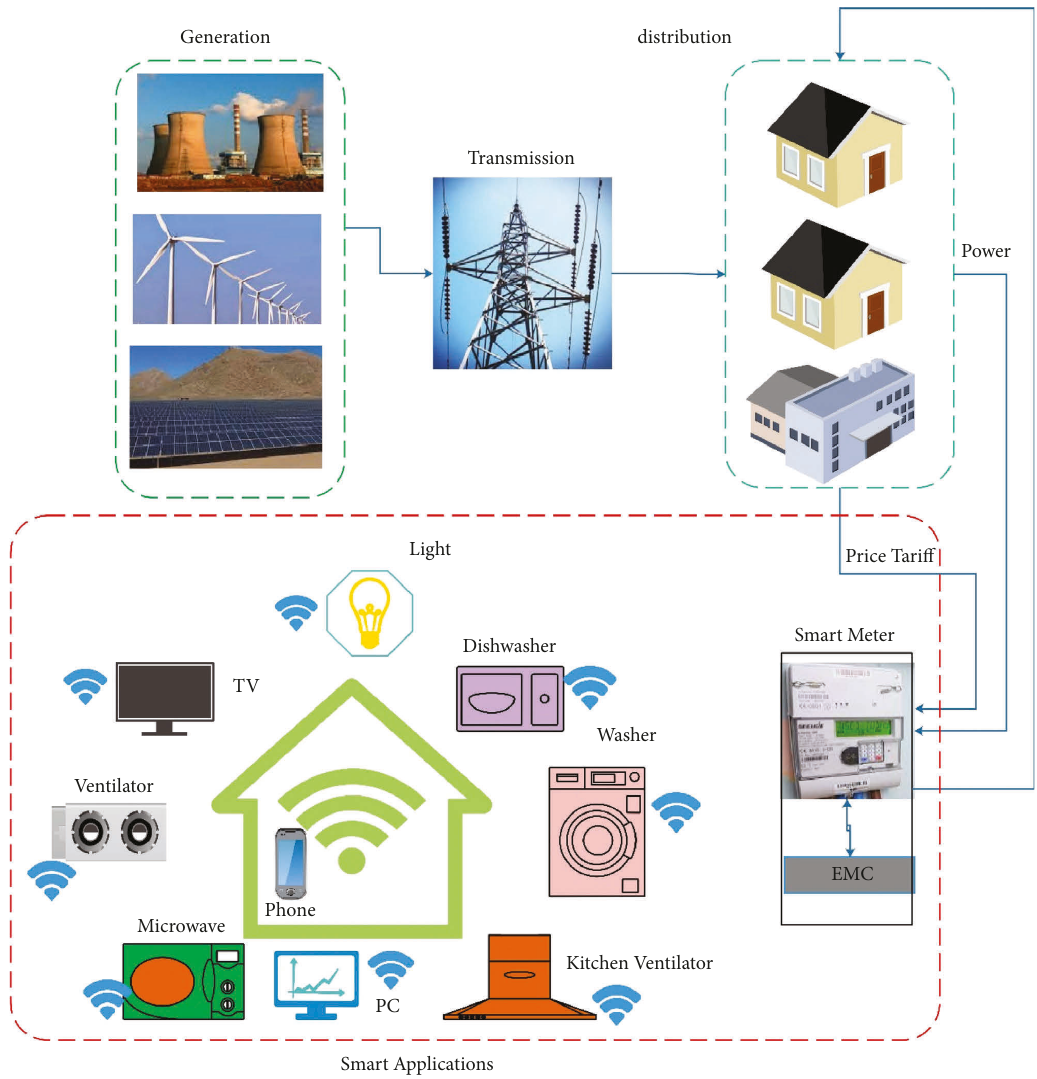
Figure 1: Proposed system